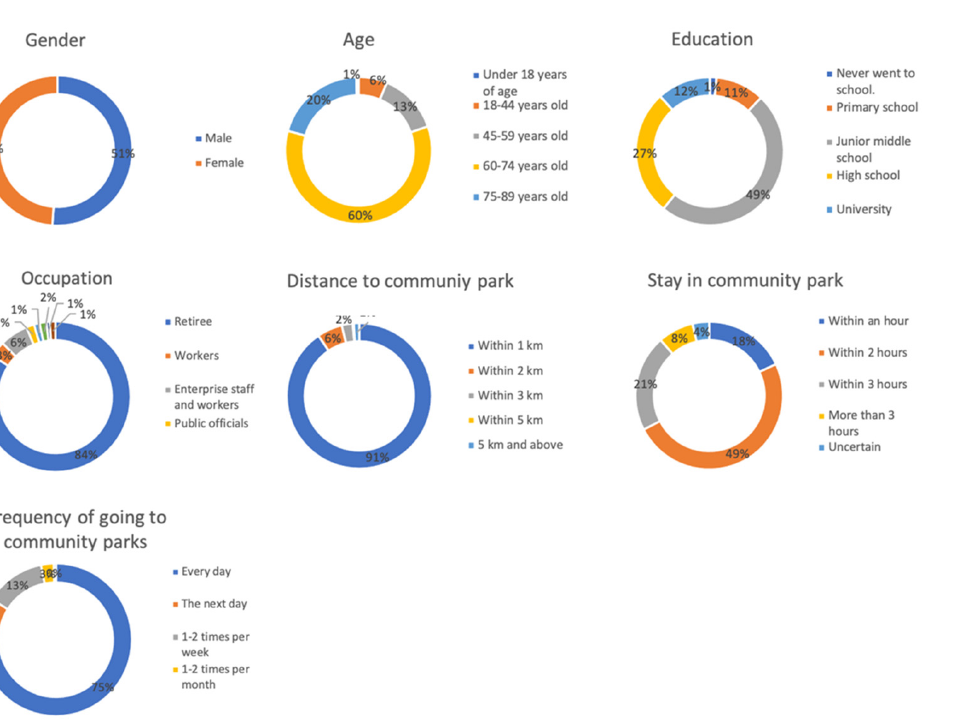
Figure 6. Basic information of community park users.